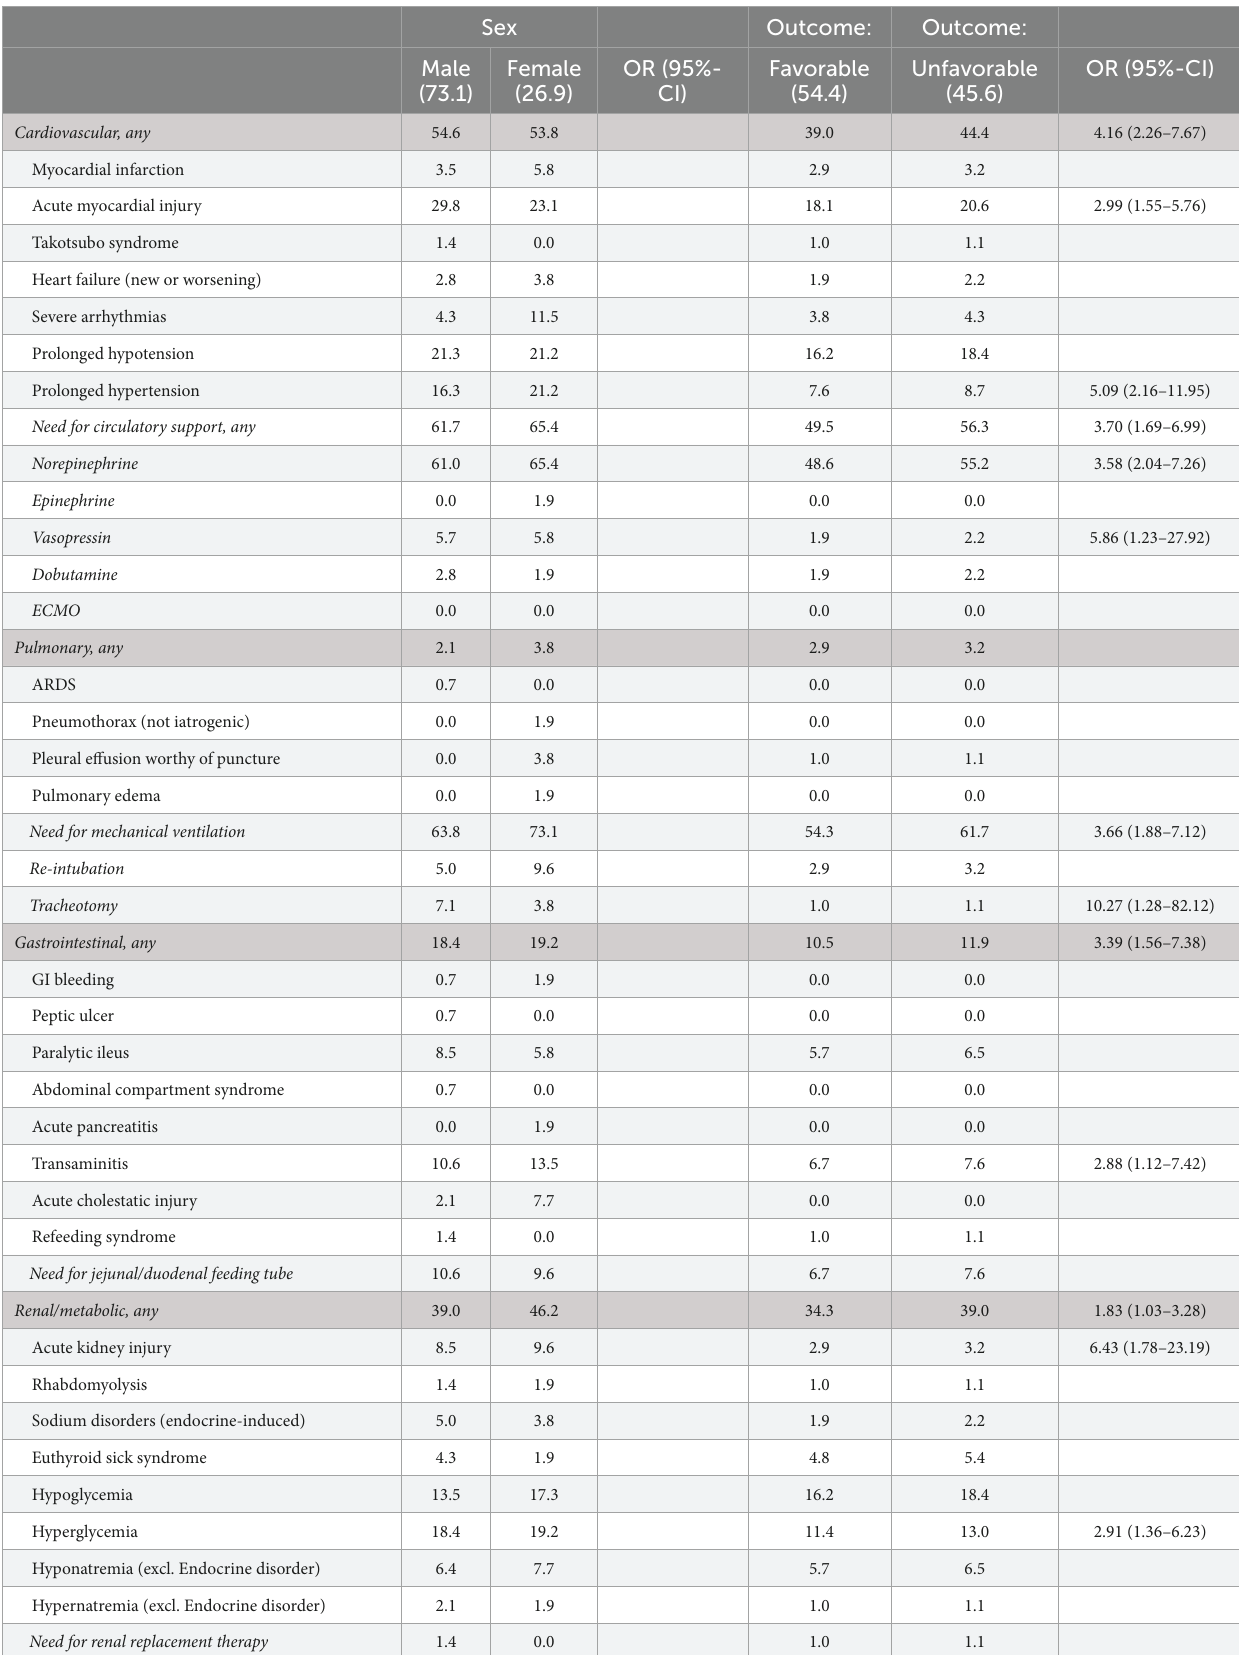
TABLE 4 Complications dichotomized by sex and outcome (iTBI only).